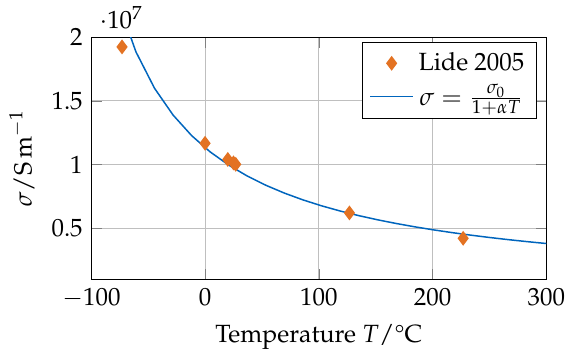
Figure 4. Nonlinear material law for the electrical conductivity of iron with σ 0 = 10MS/m and α = 0.00581/K in comparison to